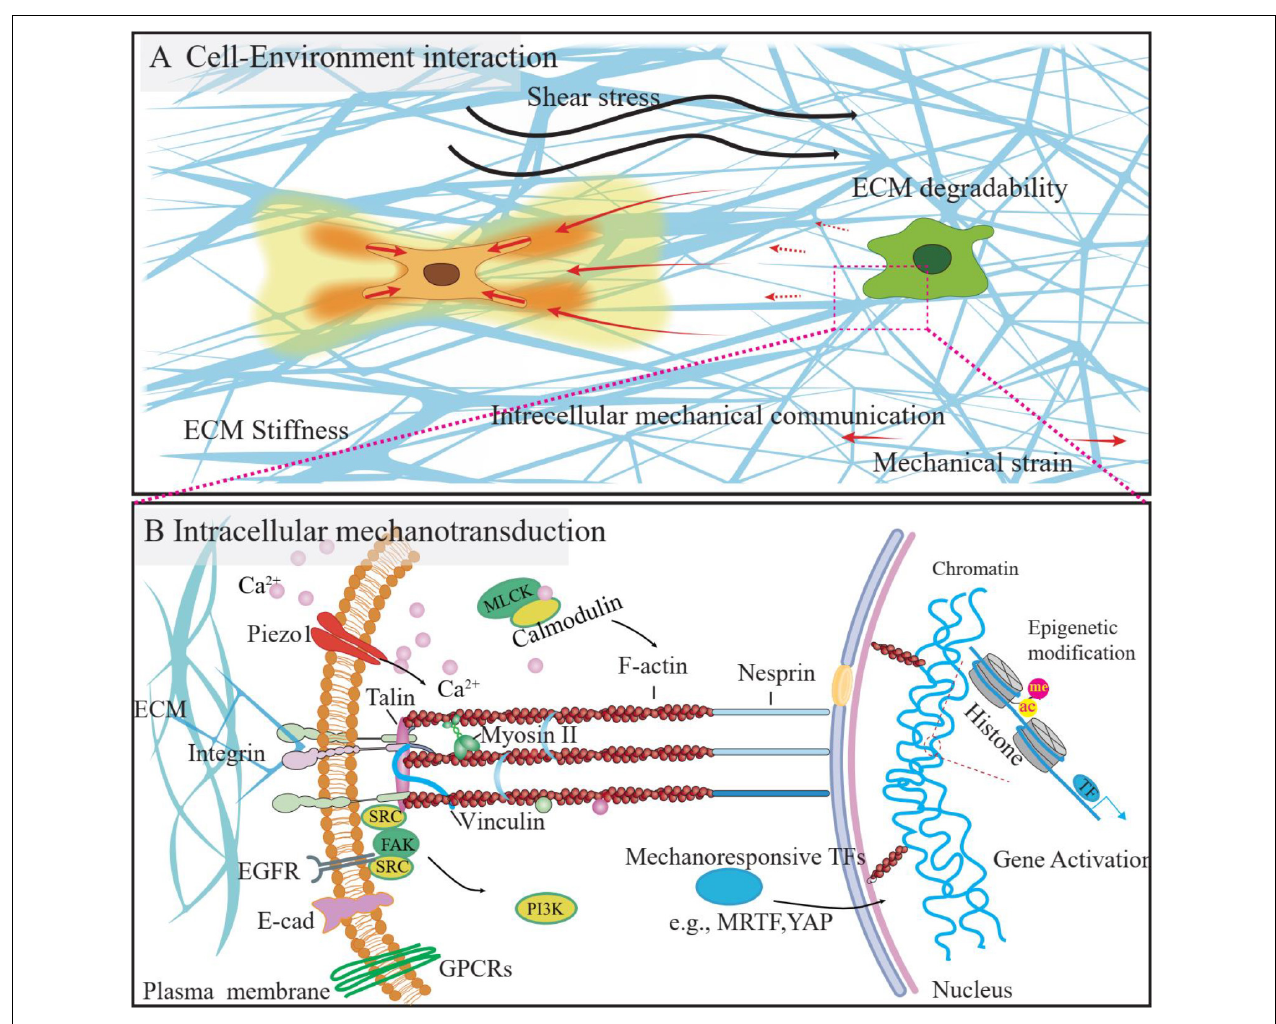
FIGURE 3 | The mechanical microenvironment and mechanotransduction process of the cells. (A) The cells reside in the 3D microenvironment, the mechanical stimulation from the microenvironment, such as the shear stress, change of ECM properties (e.g., stiffness, degradability) could influence the cell function. Besides, the ECM fiber could be used as a media to transmit the mechanical strain from the neighboring cells, as a way of intercellular communications. (B) Cells could sense and respond to mechanical stimuli from the environment by converting them to intracellular biochemical signals, which process is called mechanotransduction. Several signaling pathways were identified to be involved in this process and could be visualized by using FRET biosensors, as listed